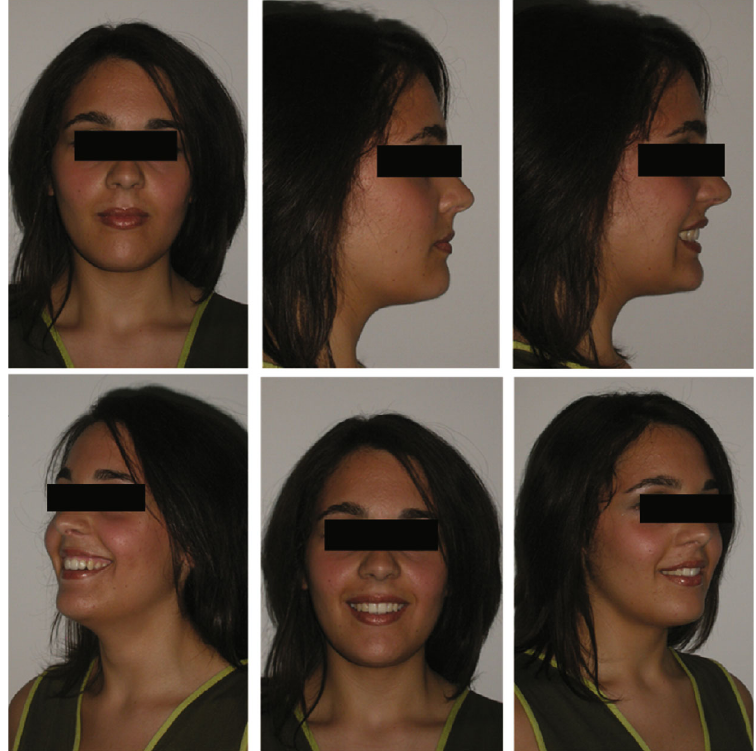
Figure 13: 4-year follow-up extraoral